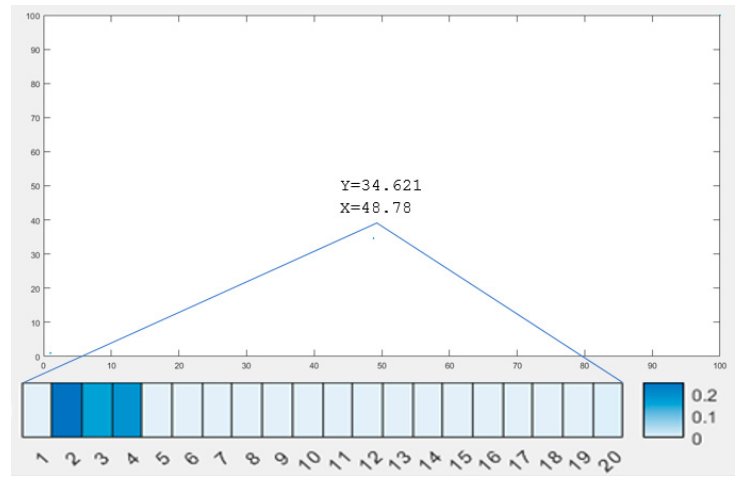
Figure 20. Grid code.